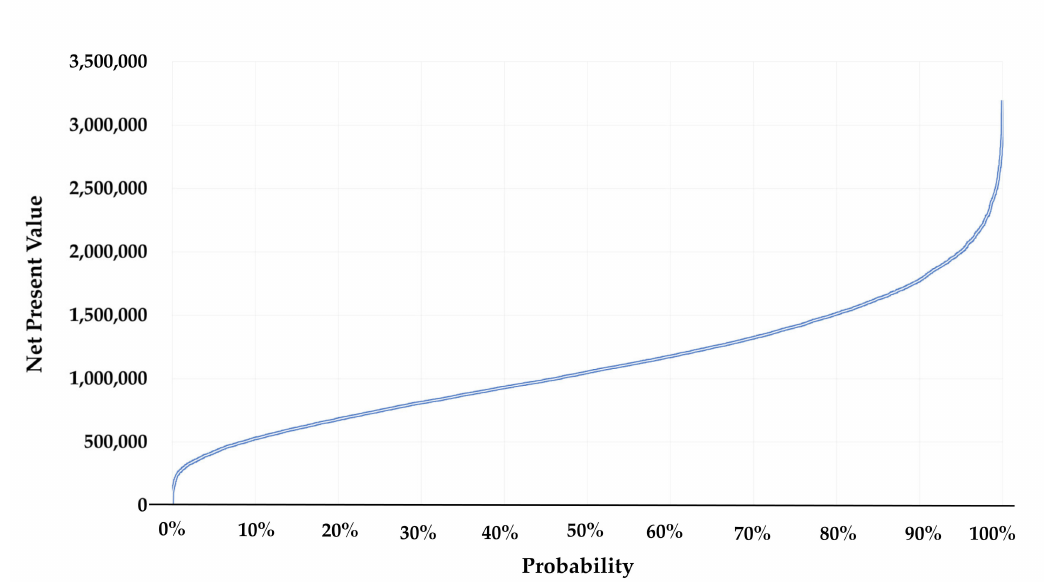
Figure 6. Cumulative probability of net present value (Monte Carlo analysis, x -axis: cumulative percentage, y -axis: net present value, and unit: Int’l